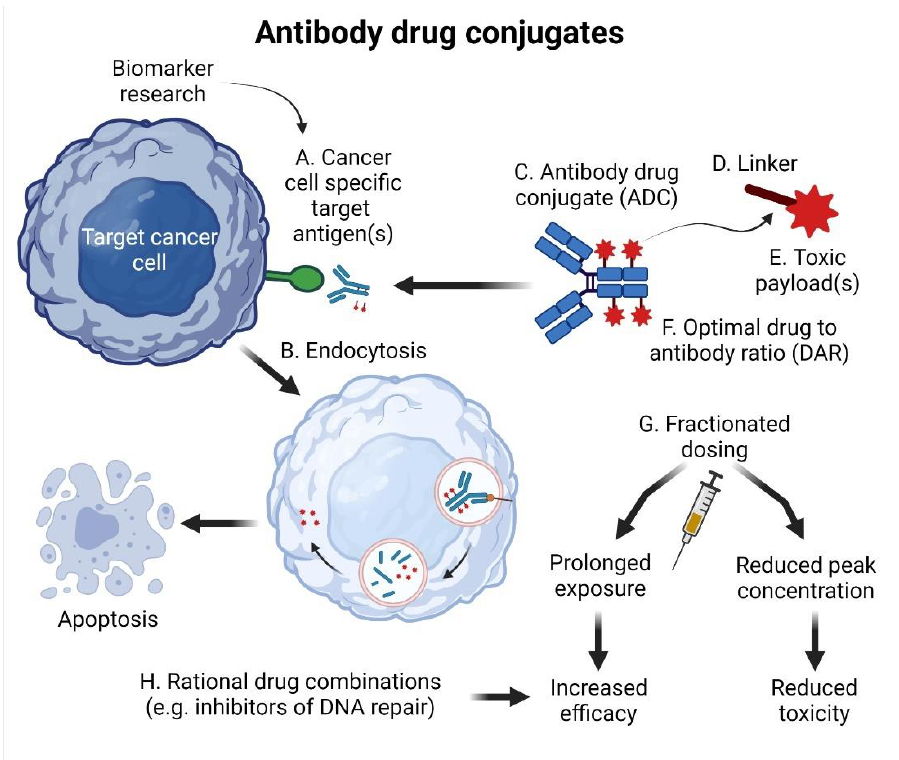
Figure 2. Mode of action of currently approved ADCs and the potential improvement of next- generation ADCs. The efficacy of next-generation ADCs might be impacted by the following features: ( A ) identification of suitable cancer cell-specific antigens; ( B ) development of ADCs that will foster receptor-mediated endocytosis; ( C ) modification of MAbs that would improve the pharmacokinetics of ADC; ( D ) innovative linkers that would induce cancer cell-specific cleavage of ( E ) more effec- tive payloads bound with ( F ) increased DAR; ( G ) optimized dosing schedules; ( H ) rational drug combinations. Created with BioRender 20 / 12 / 2021.